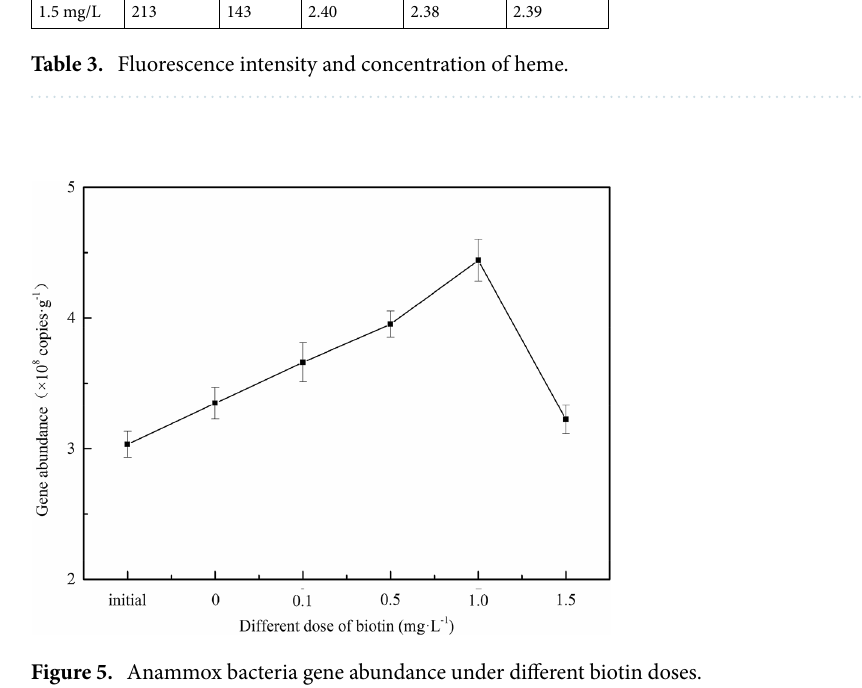
Figure 5. Anammox bacteria gene abundance under different biotin